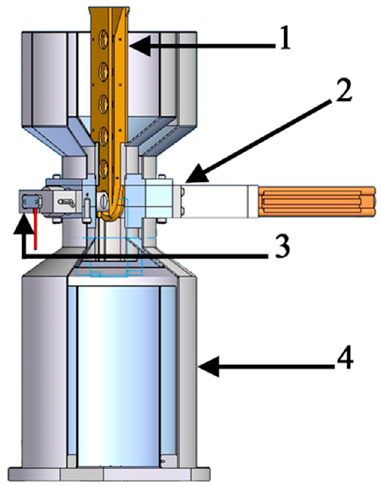
Figure 1. Schematic diagram of thermal treatment with marked recording time limits and dilato- metric measurements.